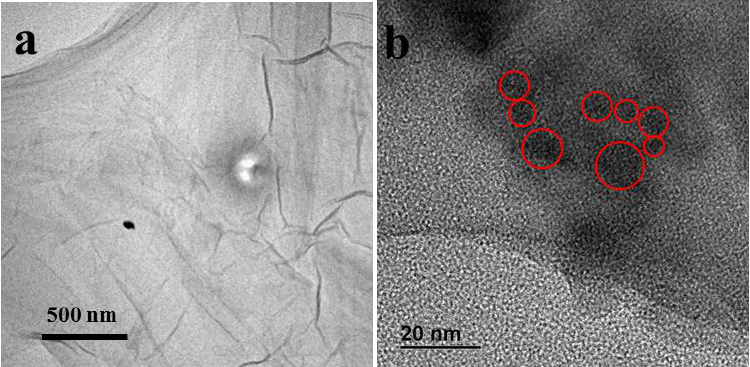
Figure 3. TEM image of ( a ) GO, and ( b ) CDs/rGO (5:1), some CDs are circled in red.